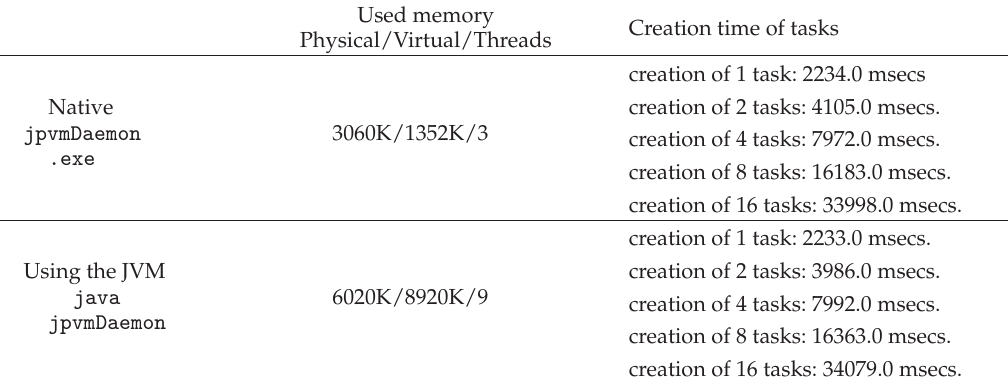
Table 1: Required memory.